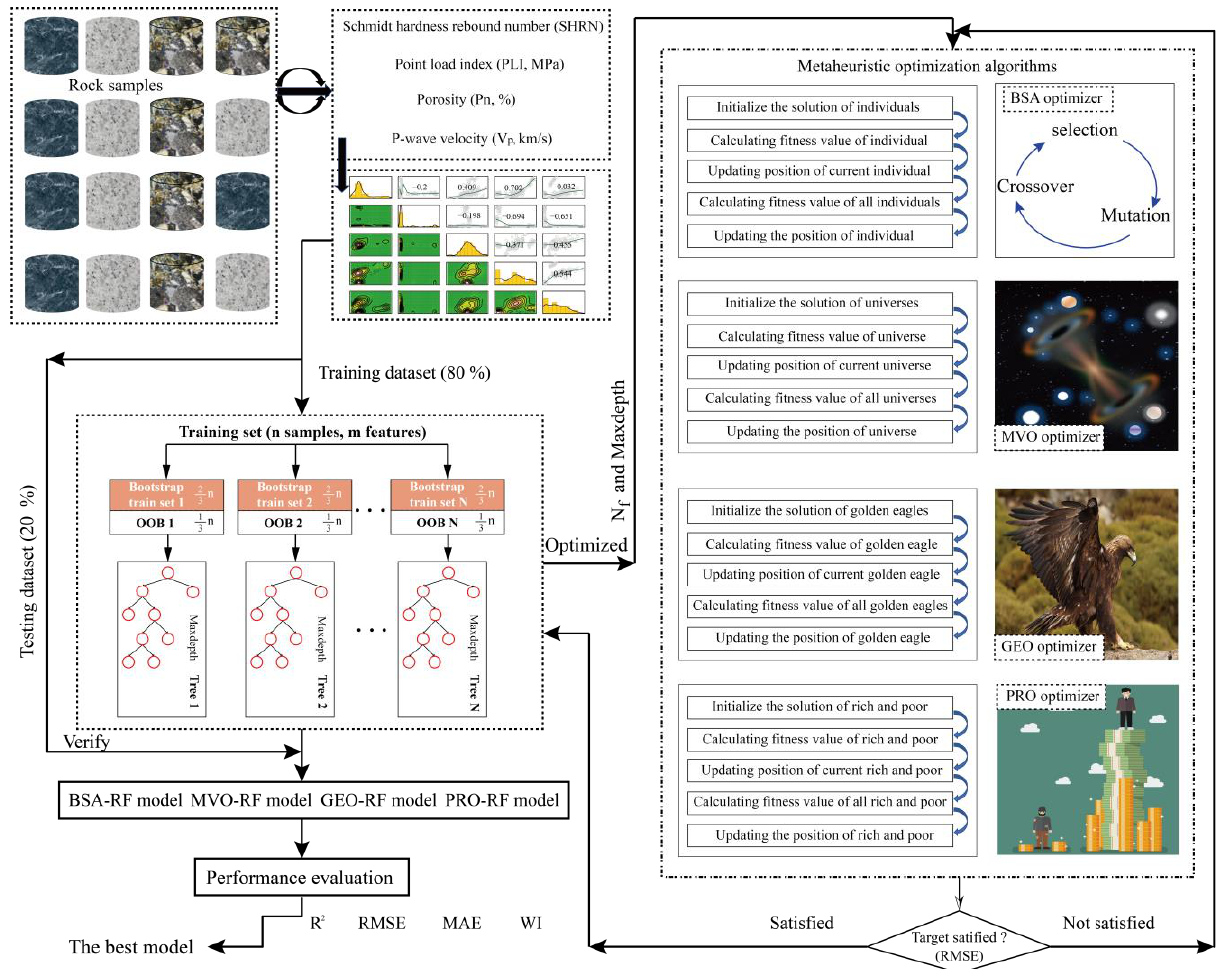
Figure 5. Flowchart of predicting the rock EM based on the four hybrid RF models.